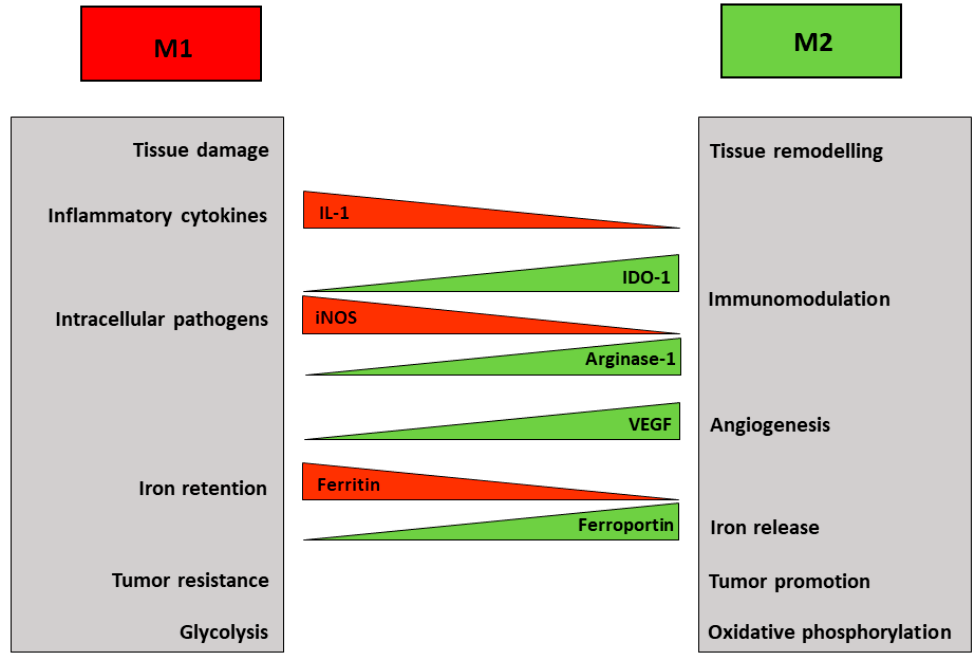
Figure 1. M1 and M2 macrophages represent the extremes of a spectrum. The major properties and functions of polarized macrophages are summarized in the boxes. The differential expression of representative molecules and effectors is also shown.